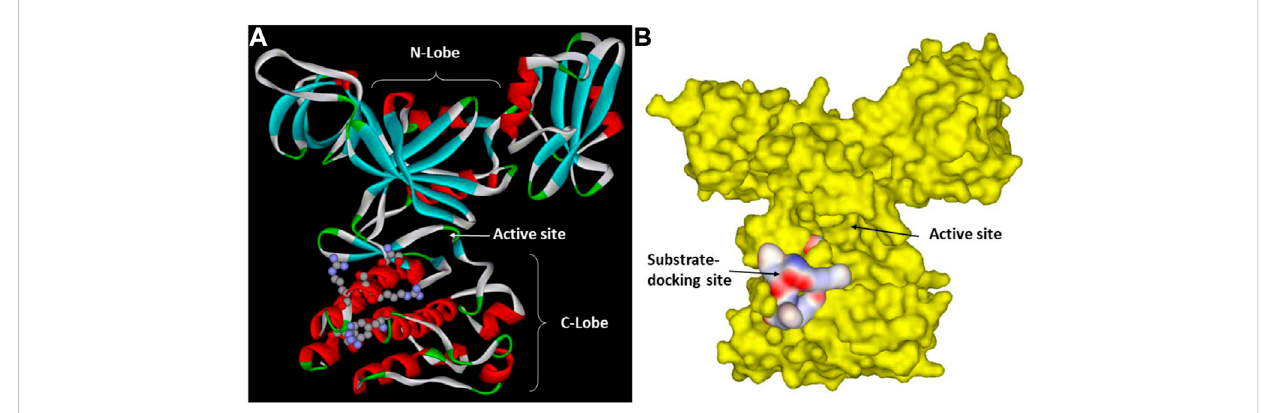
FIGURE 2 Csk substrate docking site. (A) . Csk ribbon structure with the key residues in the substrate docking site shown in ball and stick. The N-lobe, C-lobe and the active site cleft of Csk are indicated to show their positions relative to the substrate-docking site. (B) . Surface structure of Csk and the substrate- docking site colored by the electric